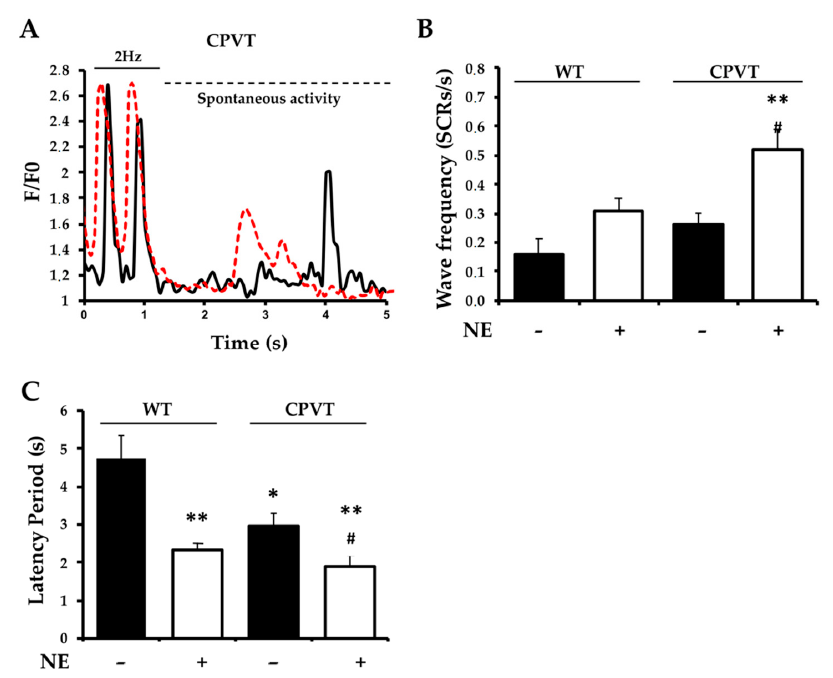
Figure 4. Pace-stop stimulation protocol unmasks spontaneous untriggered Ca 2+ release in CPVT slices. ( A ) Fluorescence profiles of CMs within cardiac slice from heterozygous RyR2 RS/wt mice, in control conditions (black trace) and during NE administration (red trace), showing a representative trace of a SCR. ( B ) Quantification of SCRs in the slices from WT and CPVT hearts at baseline and in the presence of NE. Error bars represent SD (** p < 0.01 compared to WT plus NE; # p < 0.001 compared to CPVT in basal condition). ( C ) WT and CPVT slices showed significantly different latency time before the first spontaneous Ca 2+ release event. Error bars represent SD (* p < 0.05 compared to WT; ** p < 0.01 compared to WT; # p < 0.05 CPVT in basal condition vs. NE administration).